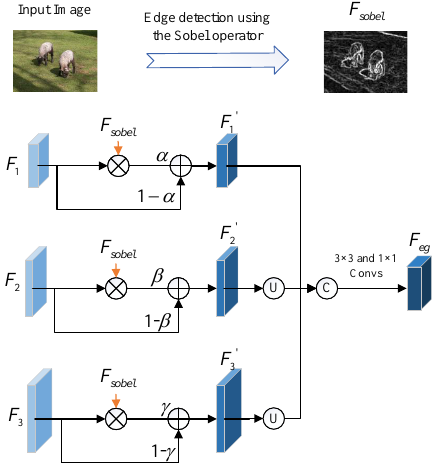
Table 1. PASCAL-5 i (PASCAL VOC 2012, SBD).